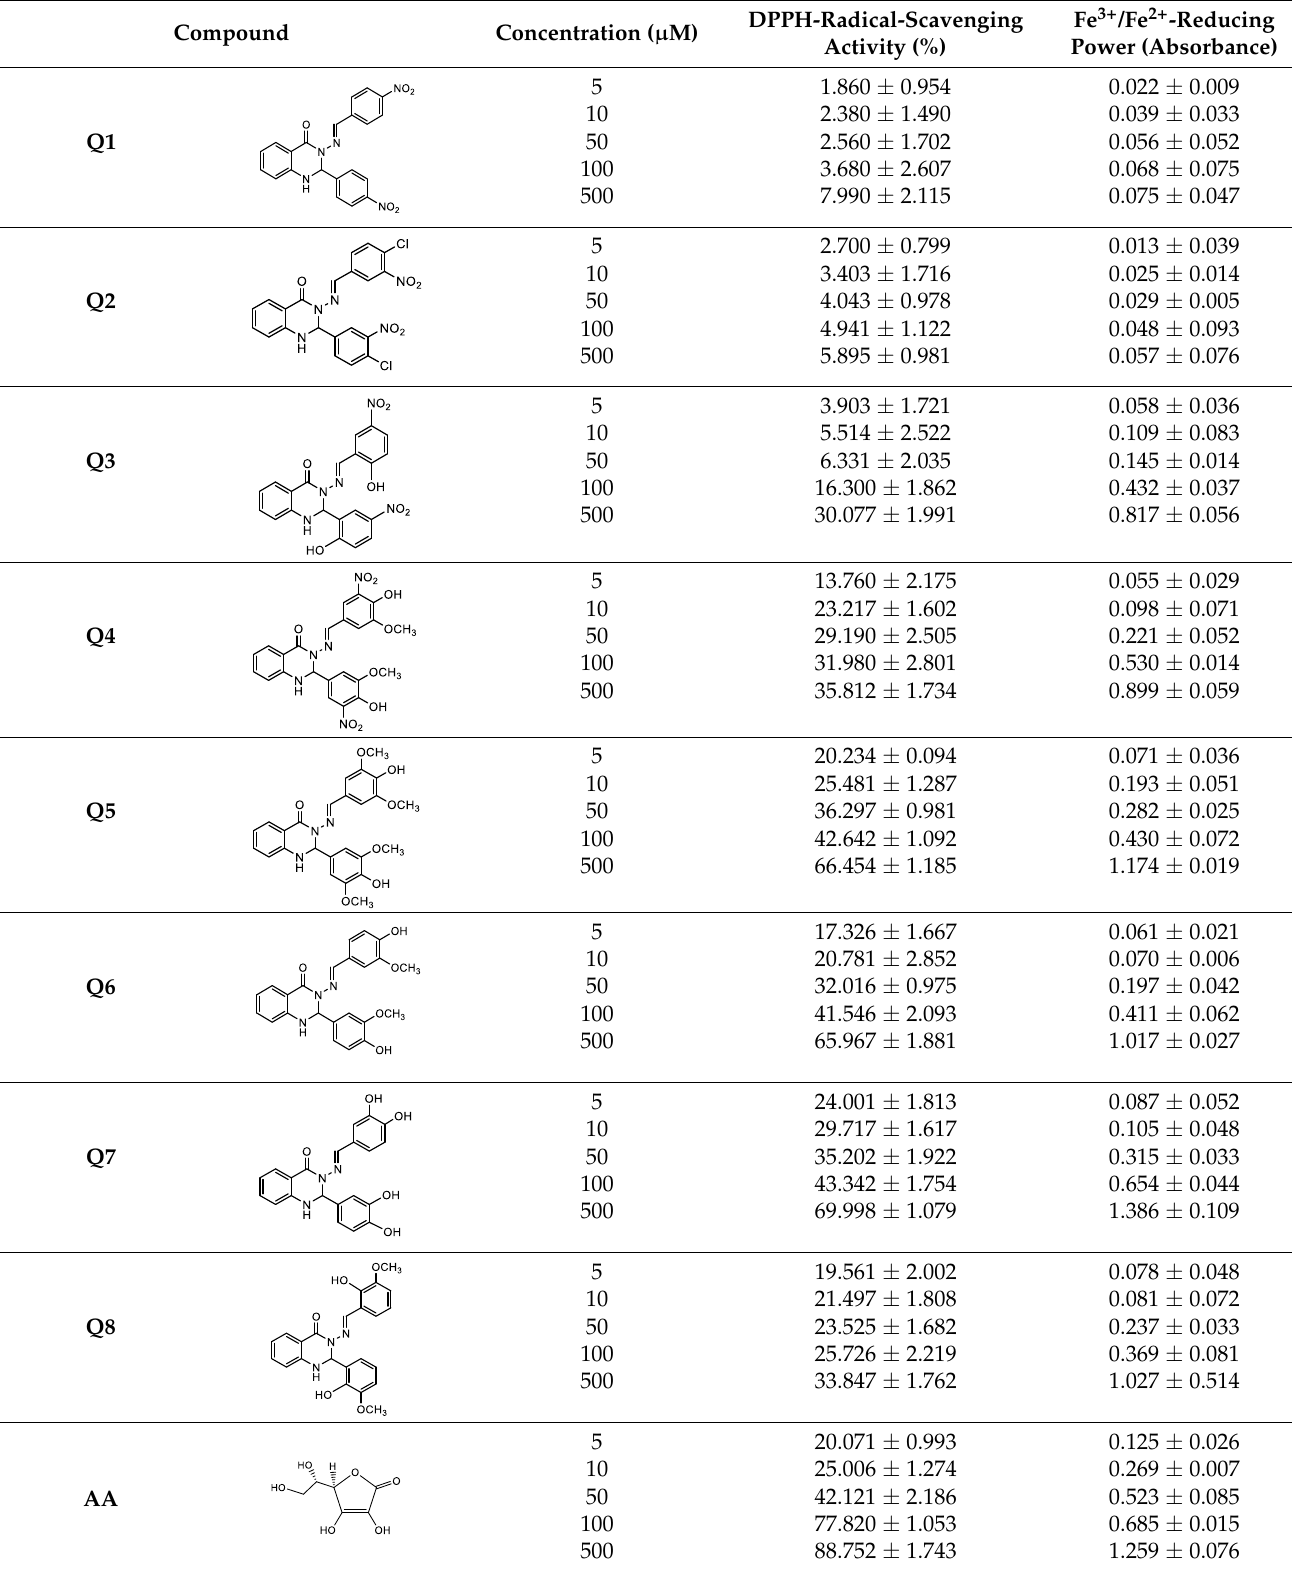
Data represent the means ± standard deviations (SD) of three independent experiments; ascorbic acid (AA) was used as a positive control.